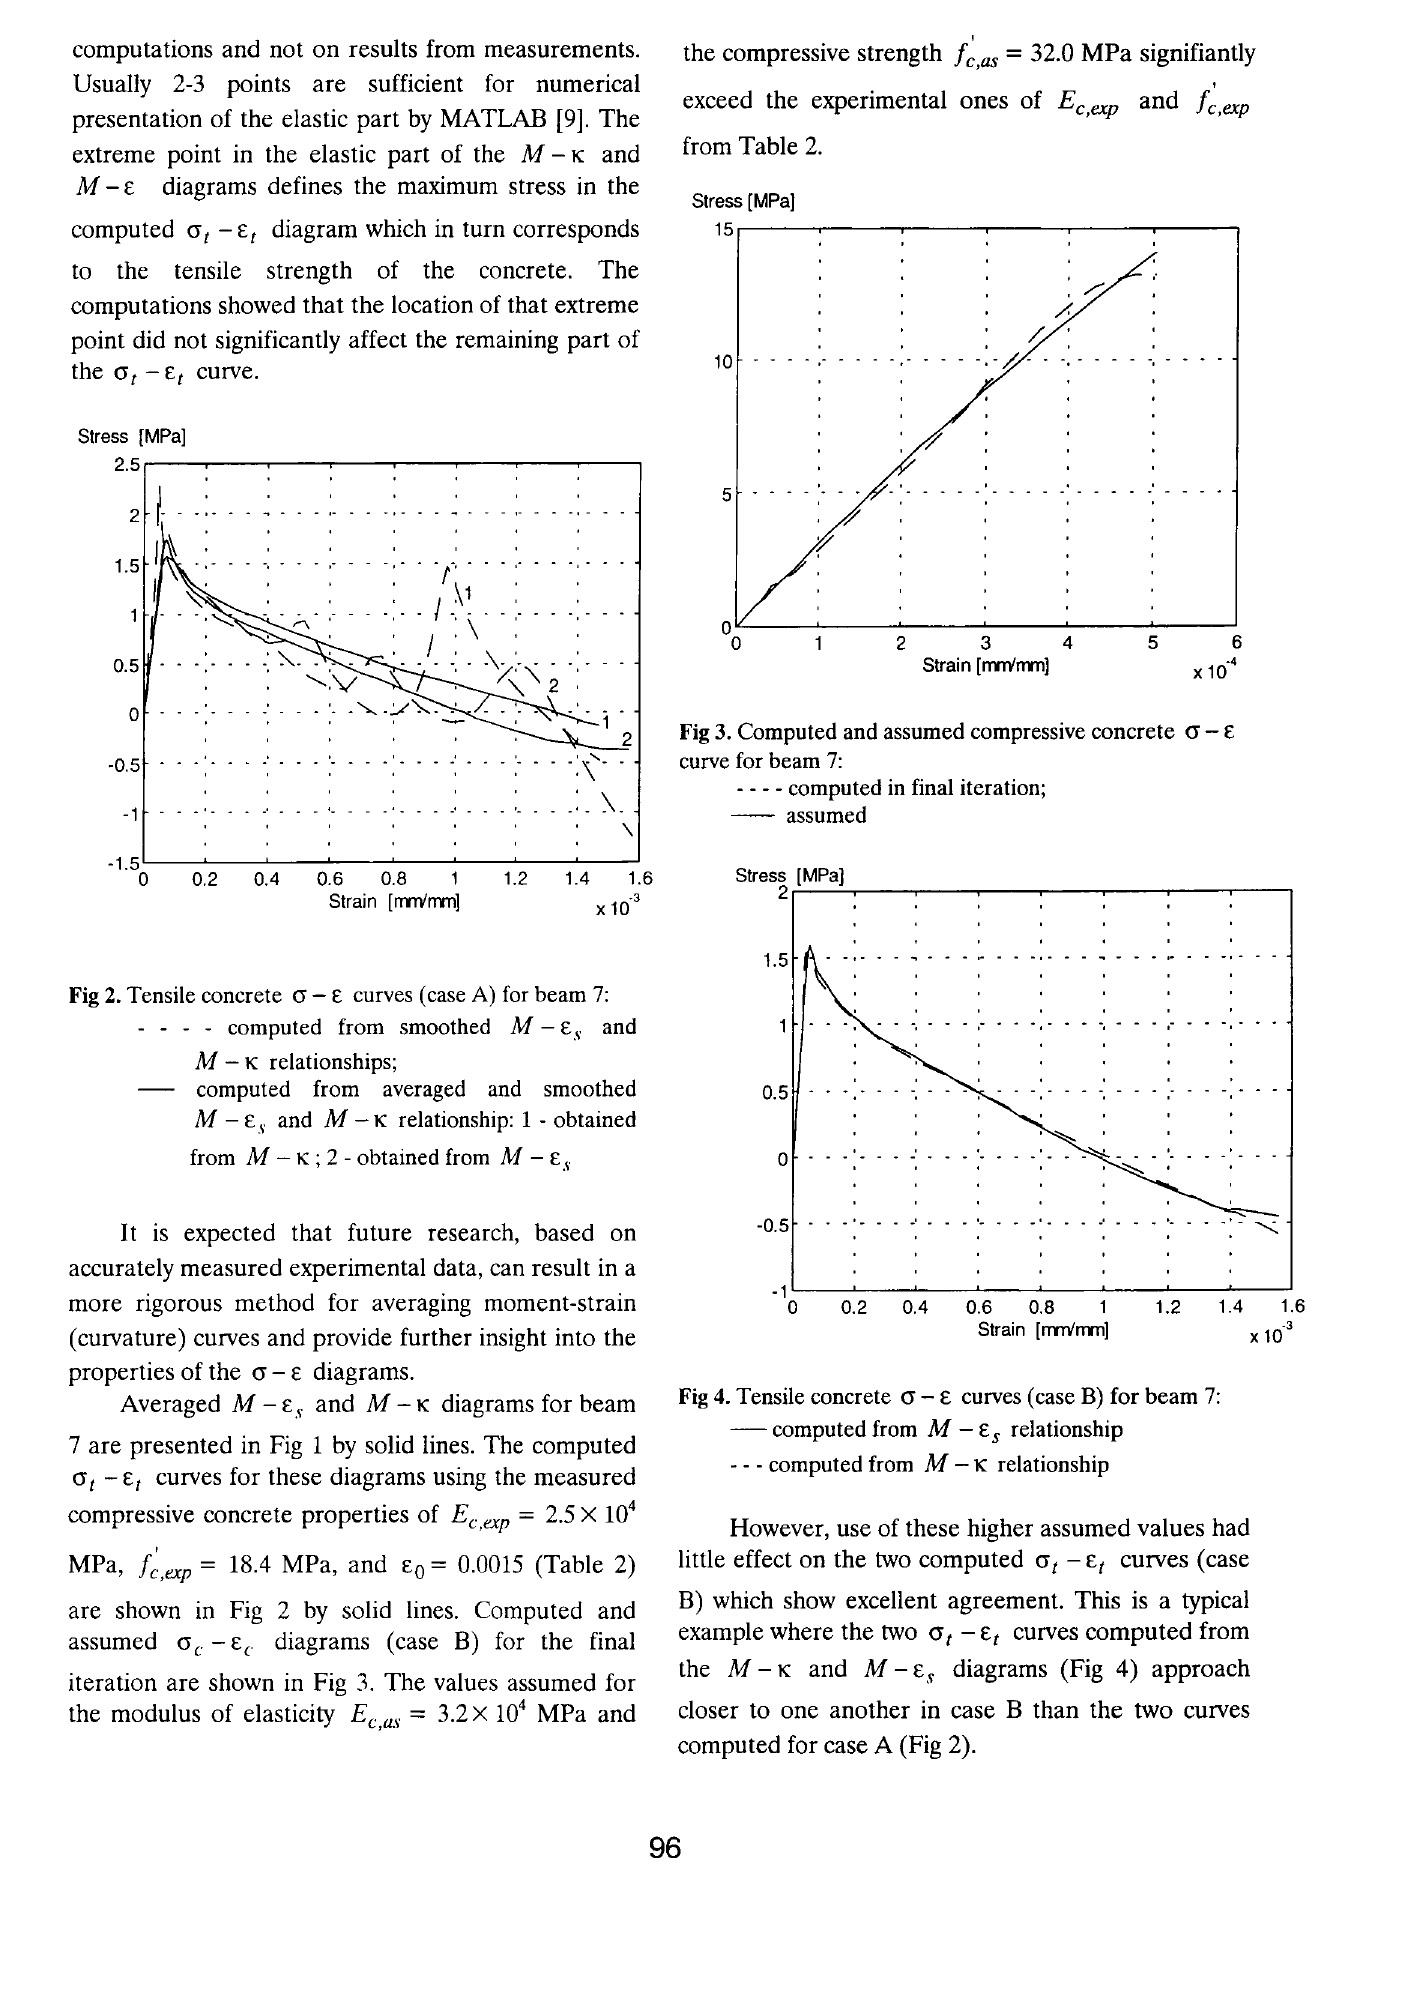
Fig 3. Computed and assumed compressive concrete cr- E curve for beam 7: - - - - computed in final iteration; --assumed